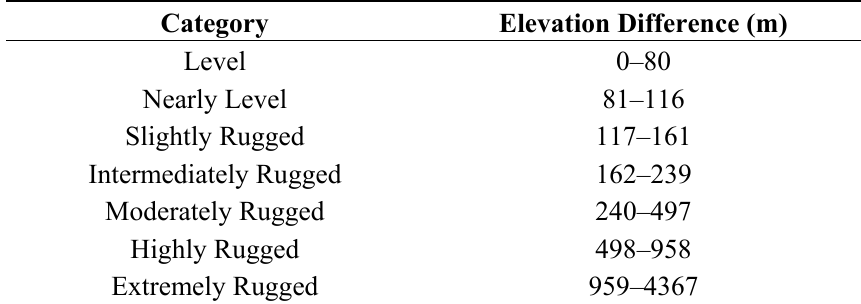
Table 2. Terrain Ruggedness Index (TRI) Categories (from Riley et al.